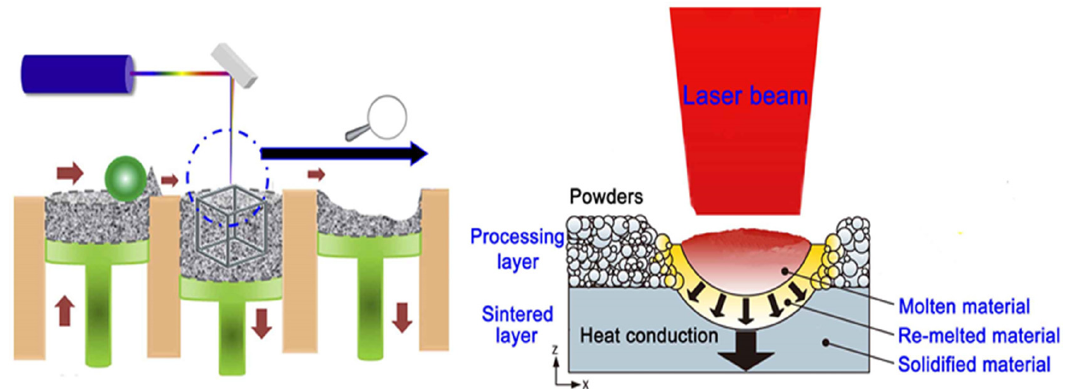
Figure 2. The processing principle of SLM technology .